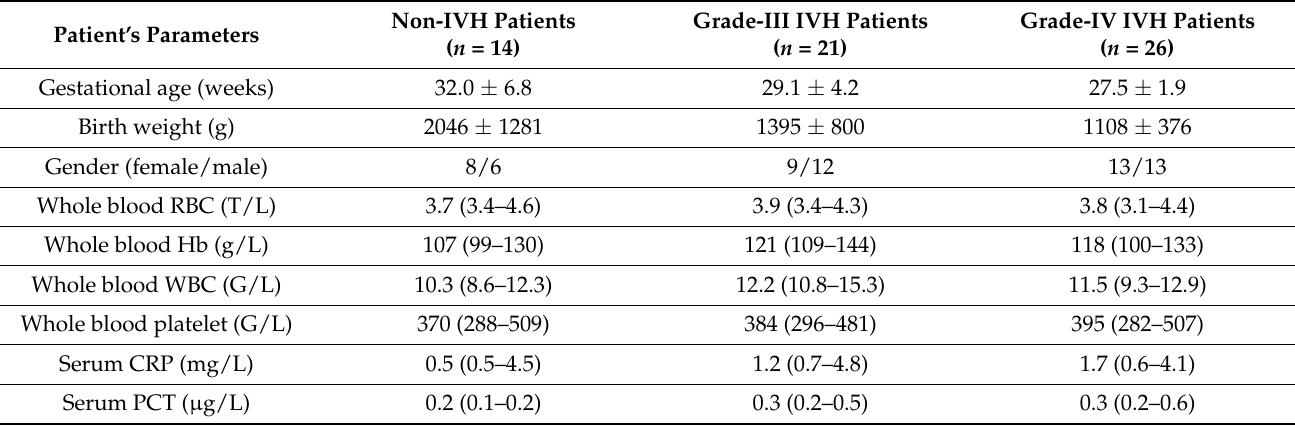
Table 1. Baseline demographical and routine laboratory characteristics of IVH patients and clinical controls ( n indicates the number of involved subjects). Data are expressed as mean ± SD or median with IQR. For statistical analyses, chi-square test and unpaired t -test or Mann–Whitney U test were used, as